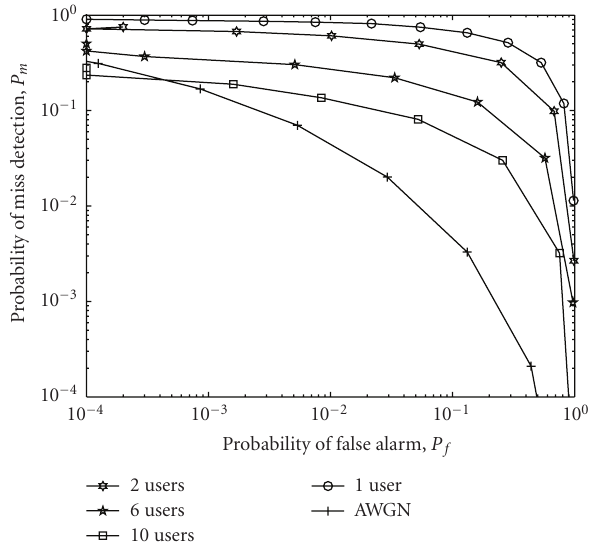
Figure 5: Receiver operating characteristics for collaborative spec- trum sensing under shadowing, σ dB = 10, N = 5.